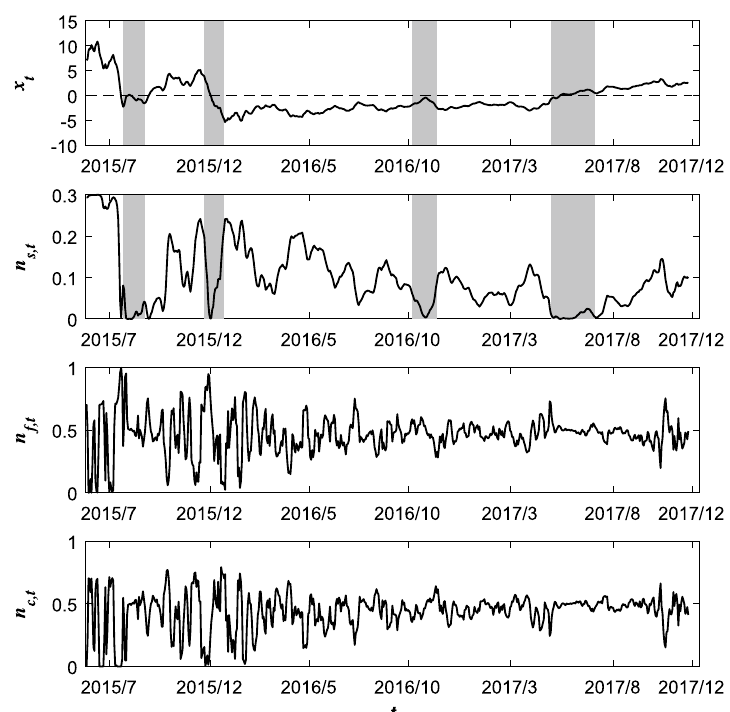
Fig. 5 Realized deviation (top panel) and the corresponding market fraction of stabilizers (second panel), fundamentalists (third panel), and chartists (bottom panel), respectively, for the model specification x s = q ( 0.2 ) , n s , max = 0.3 . The shadow regions in the first two panels capture characterized periods that indicate that the fraction of stabilizers duly matches with the